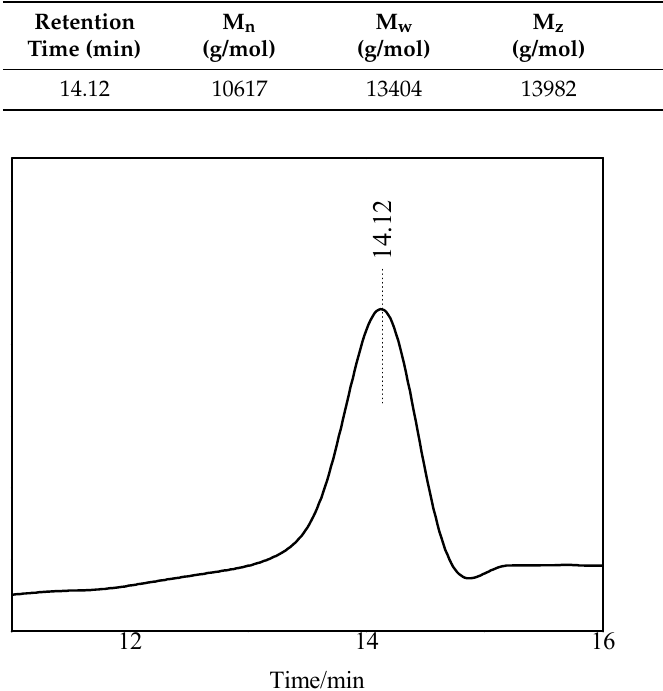
Figure 5. Gel permeation chromatography (GPC) results of the polysulfonate dispersant. Table 3. Molecular weight distribution of the polysulfonate dispersants.